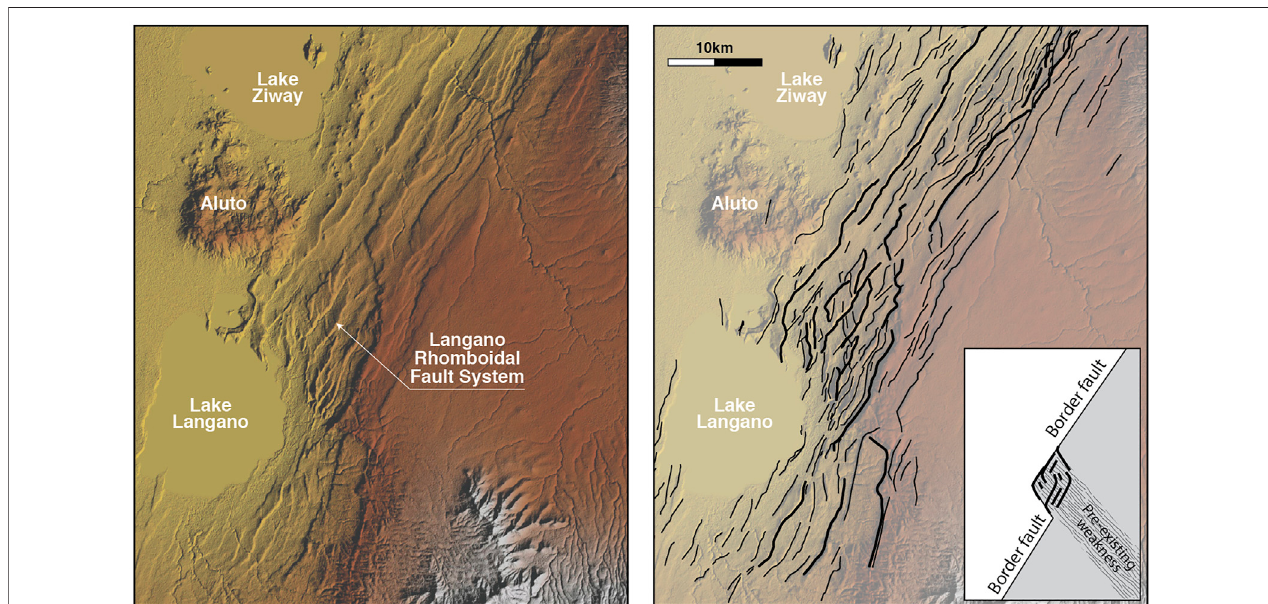
FIGURE 9 | Digital elevation model (NASA-Shuttle Radar Topography Mission, SRTM 30 m resolution; left panel), and faults superimposed onto a SRTM digital elevation model(rightpanel) oftheLangano RhomboidalFaultSystem. Insetinthebottomright showsaschematicrepresentationofthepossiblein fl uenceofaNW-SE- trending inherited weakness on the fault pattern. See text for